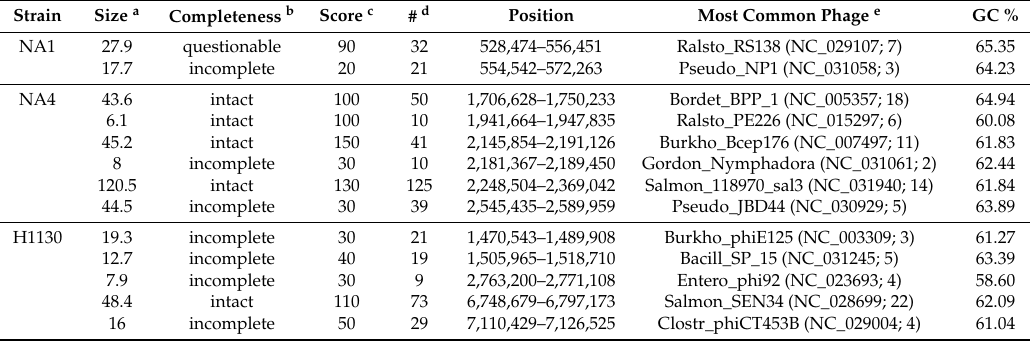
Table 2. Prophage detected in C. metallidurans NA1, NA4 and